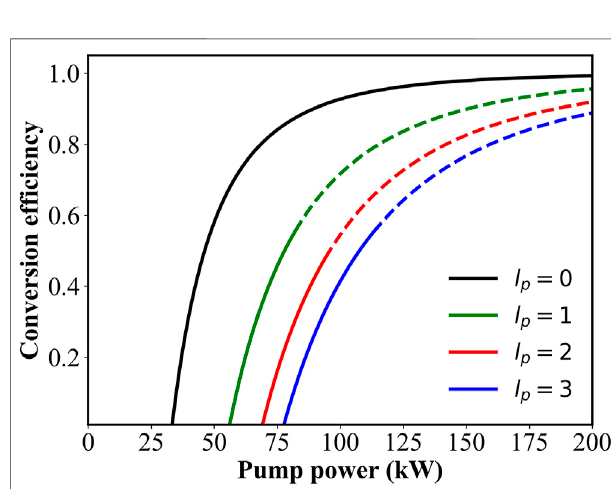
FIGURE 4 | Relationship of the conversion ef fi ciency varying with the pump power. The solid lines represent the single mode excitation (the lowest oscillation threshold is reached), and the dotted lines represent the multiple mode